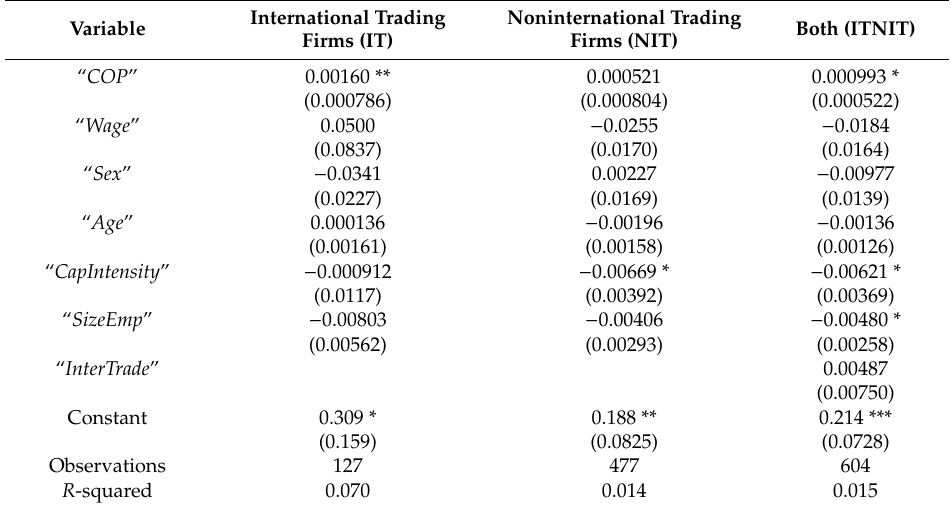
Table 11. Correlates of ROA for international trading firms and noninternational-trading firms. International Trading Variable Firms